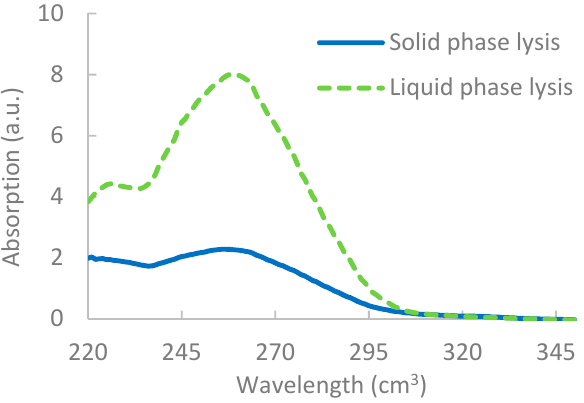
Figure 3. Results from the nanodrop showing the difference in concentration of liquid phase RPA vs. solid-phase RPA. Concentration is determined by measuring the absorption at 260 cm 3 × dilution factor × 50 ng/mL.